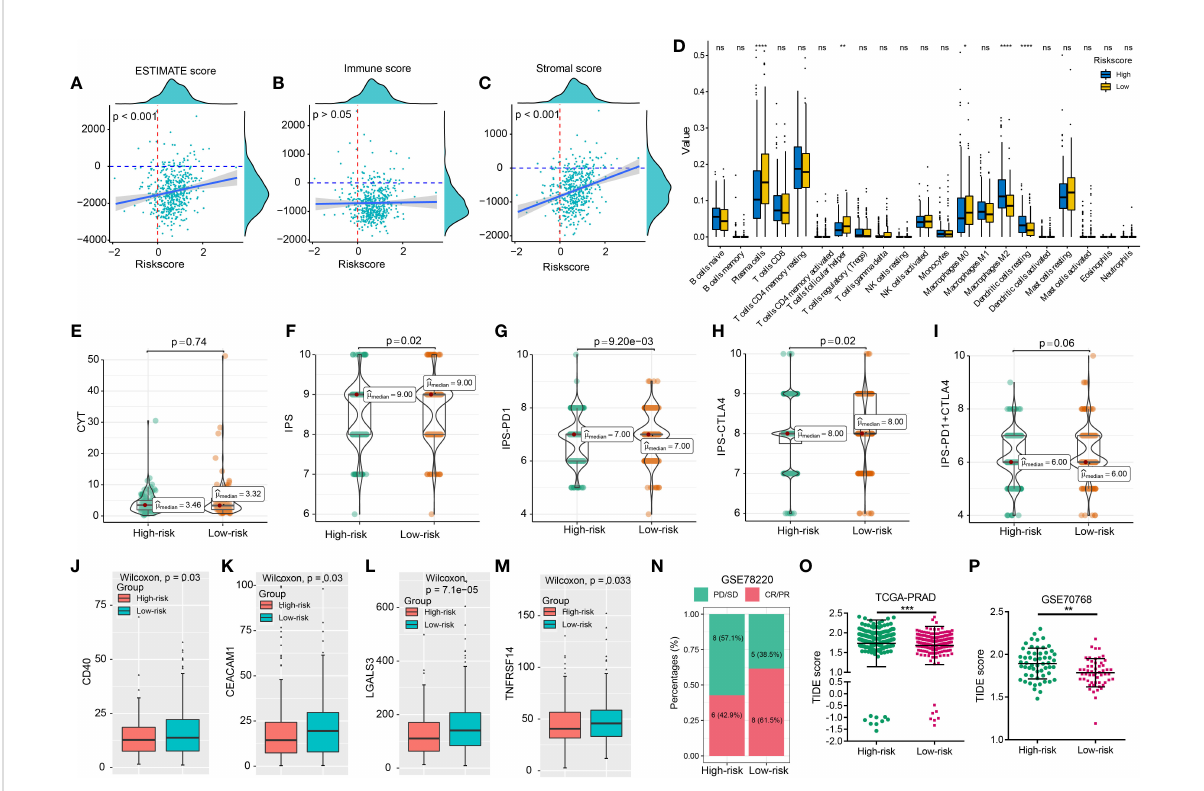
FIGURE 4 CRPGS was related to the immune characteristics of PCa. The association between riskscore and ESTIMATE, immune, and stromal scores (A – C) , and the immune pro fi les between high- and low-risk patients (D) . The distribution of CYT scores, IPS, IPS-PD1, IPS-CTLA4, IPS-PD1 +CTLA4 scores between low- and high-risk patients (E – I) . The association between riskscore and the expression levels of immune checkpoints in PCa patients (J – M) . The histogram showed the proportion of patients ’ responses in high- and low-risk groups from the GSE78220 cohort (N) . The distribution of TIDE scores in high- and low-risk patients in the TCGA-PRAD and GSE70768 cohort (O, P) . *p < 0.05; **p < 0.01; ***p < 0.001; ****p < 0.0001; ns, not signi fi